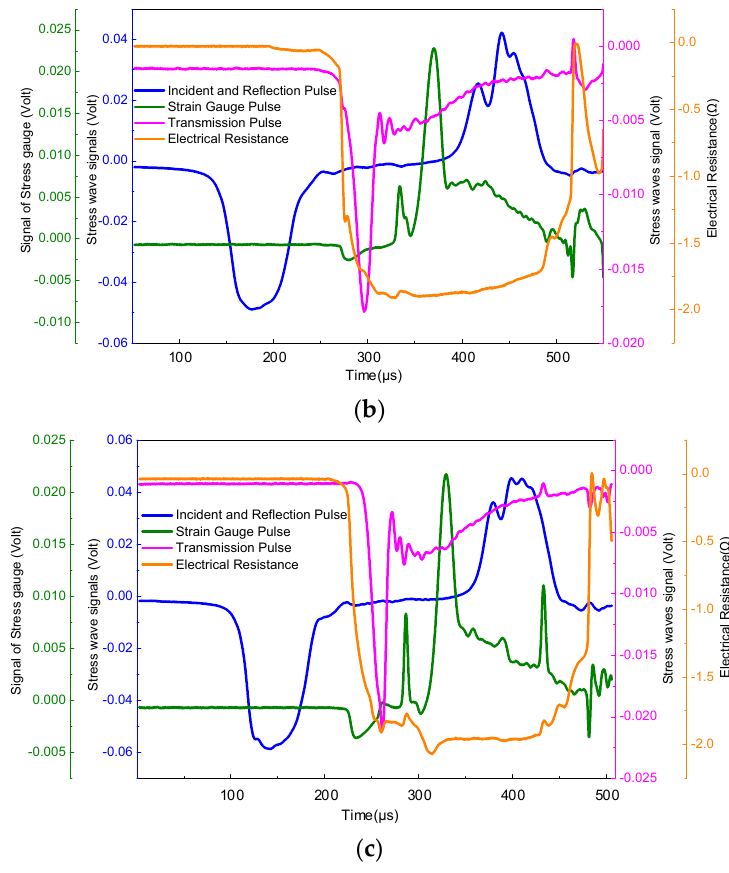
Figure 5. Hopkinson impact test results of plain weave prepreg composite. ( a ) The driving pressure of the striker is 0.3 MPa. ( b ) The driving pressure of the striker is 0.5 MPa. ( c ) The driving pressure of the striker is 0.7 MPa.